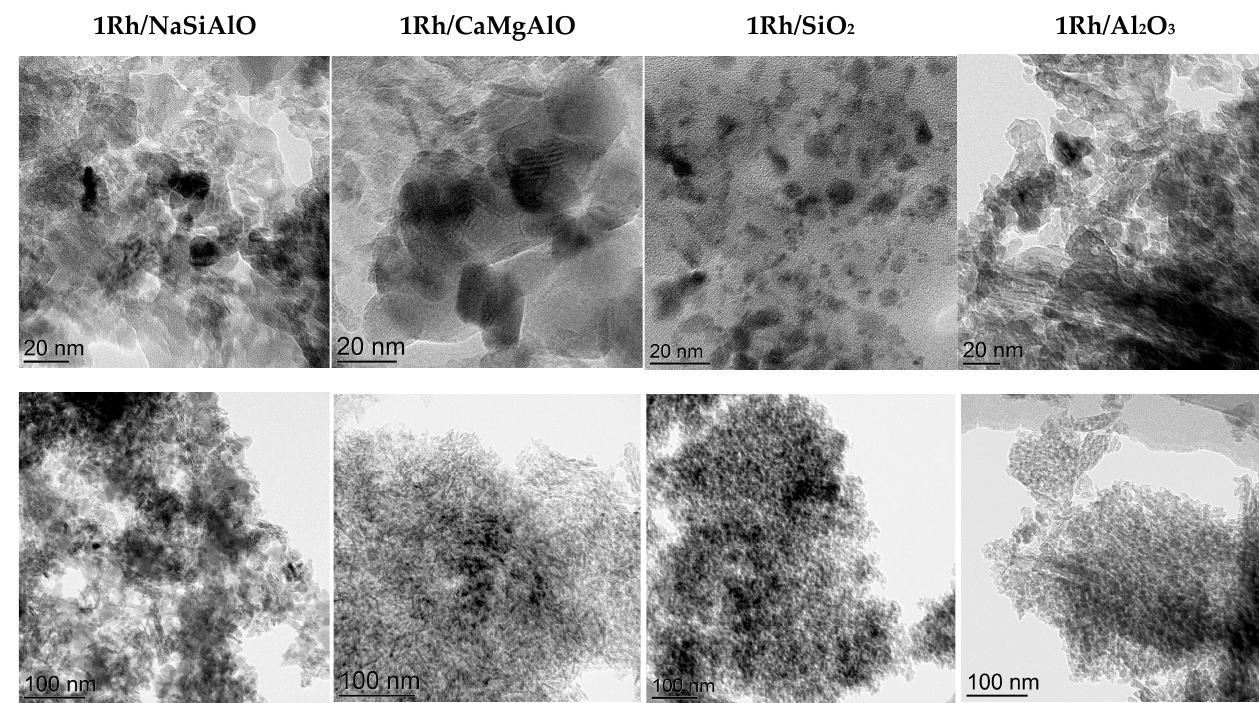
Figure 4. TEM images of the initially calcined in air catalysts with different supports. The measured interplanar spacings for the sample 1Rh/SiO 2 were 0.36, and 0.33 nm for